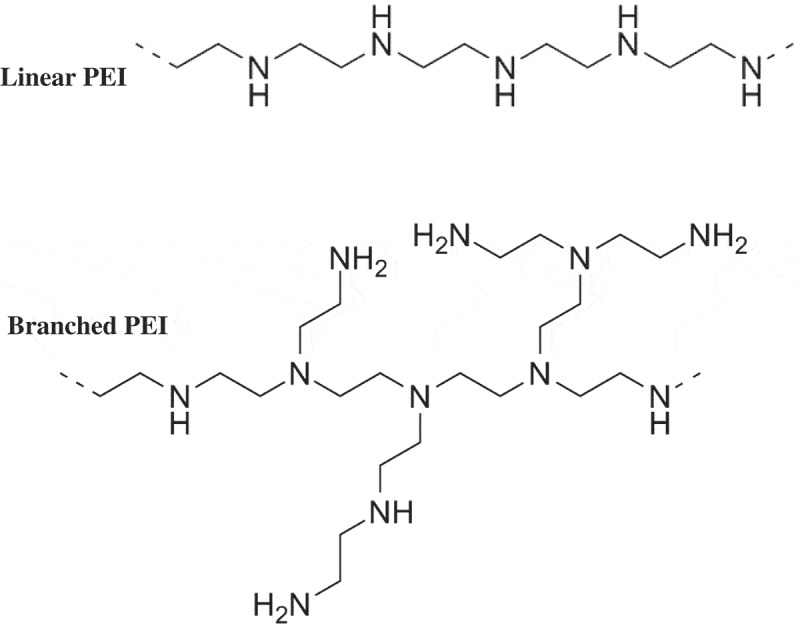
PEI Structure [15].